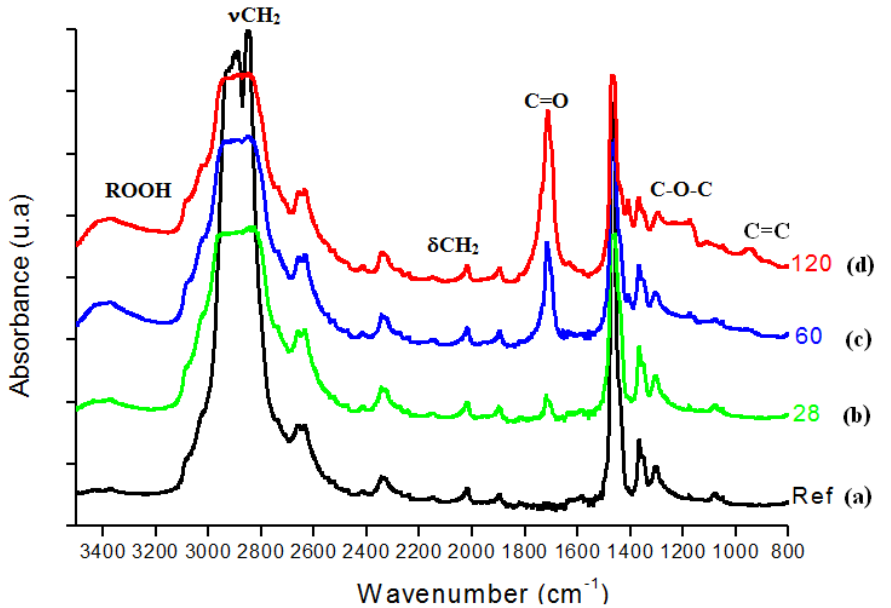
Figure 3. (a) FTIR spectra of reference UHMWPE and UHMWPE oxidized for (b) 28 days, (c) 60 days and (d) 120 days.